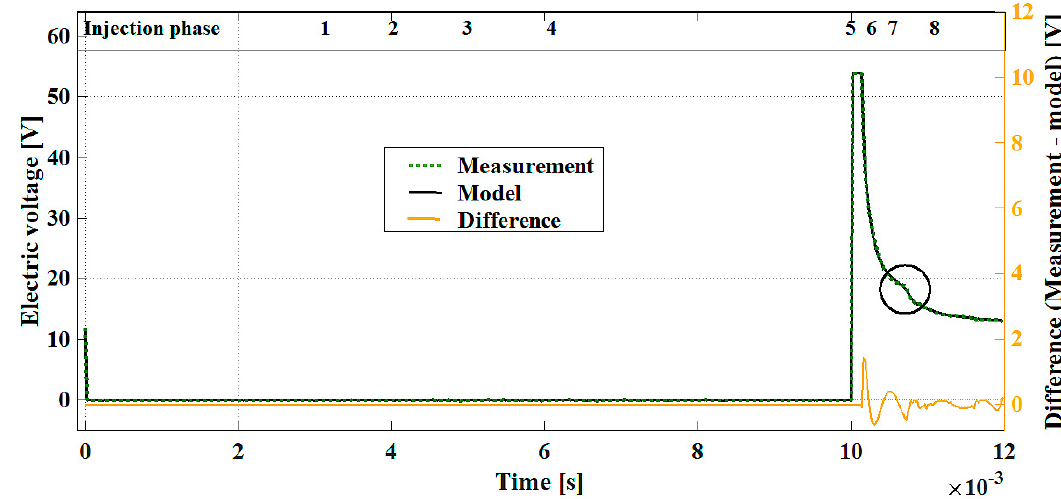
Figure 5. Measured and modeled voltage waveforms of the injector with the phases of differential equations marked.